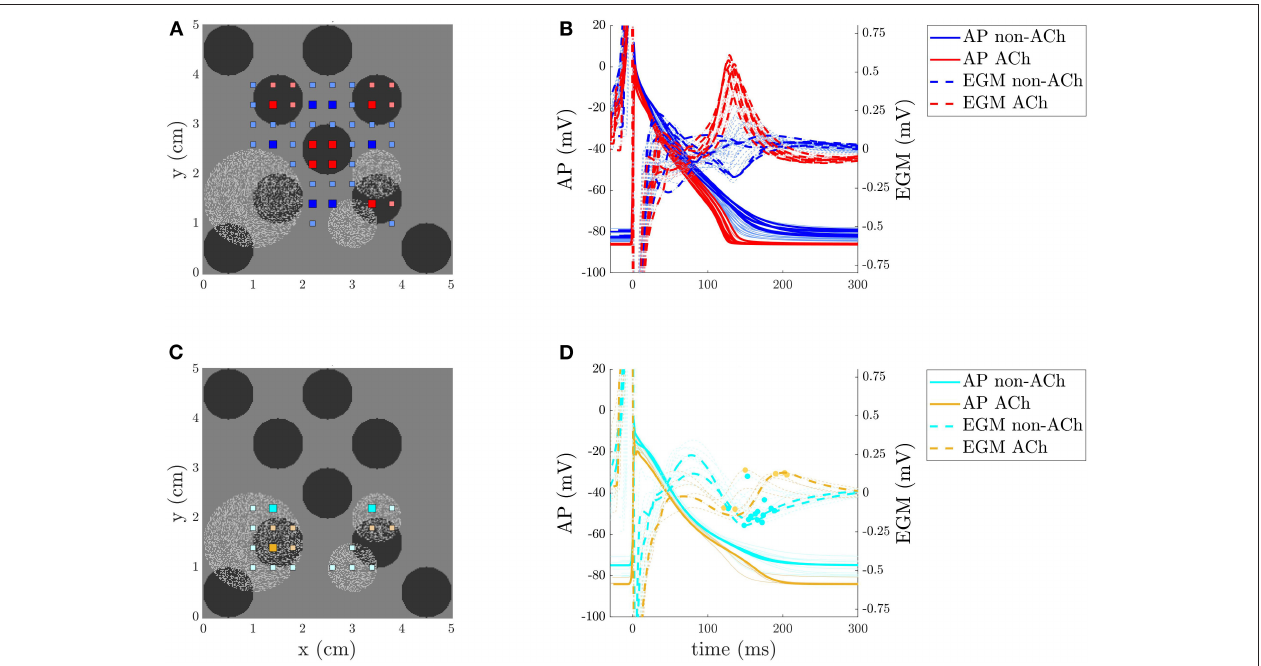
FIGURE 4 | (A,C) 2D model of a persistent AF (PsAF) tissue with ACh release sites shown in black, fibrosis in light gray, and EGM electrodes in red and blue in the non-fibrotic regions, and in orange and cyan in the fibrotic regions. (B,D) APs and EGMs were recorded in the points represented in the left panels. The thicker lines correspond to the points represented with the big squares in the tissue. In (D) the peaks of the R i , j ( t ) waves are highlighted with a